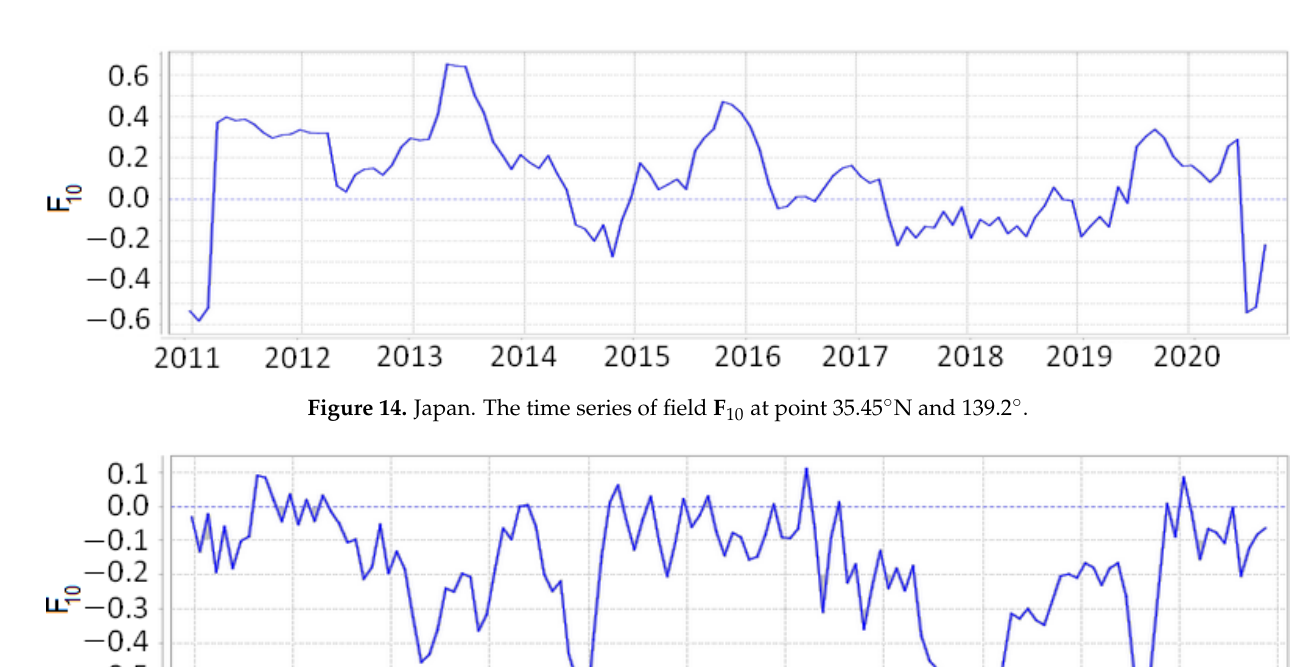
Figure 13. California. Time series at point 39.49 ◦ N and 123.2 ◦ W. ( A ) Field F 7 ; ( B ) field F 8 ; ( C ) field F 9 .